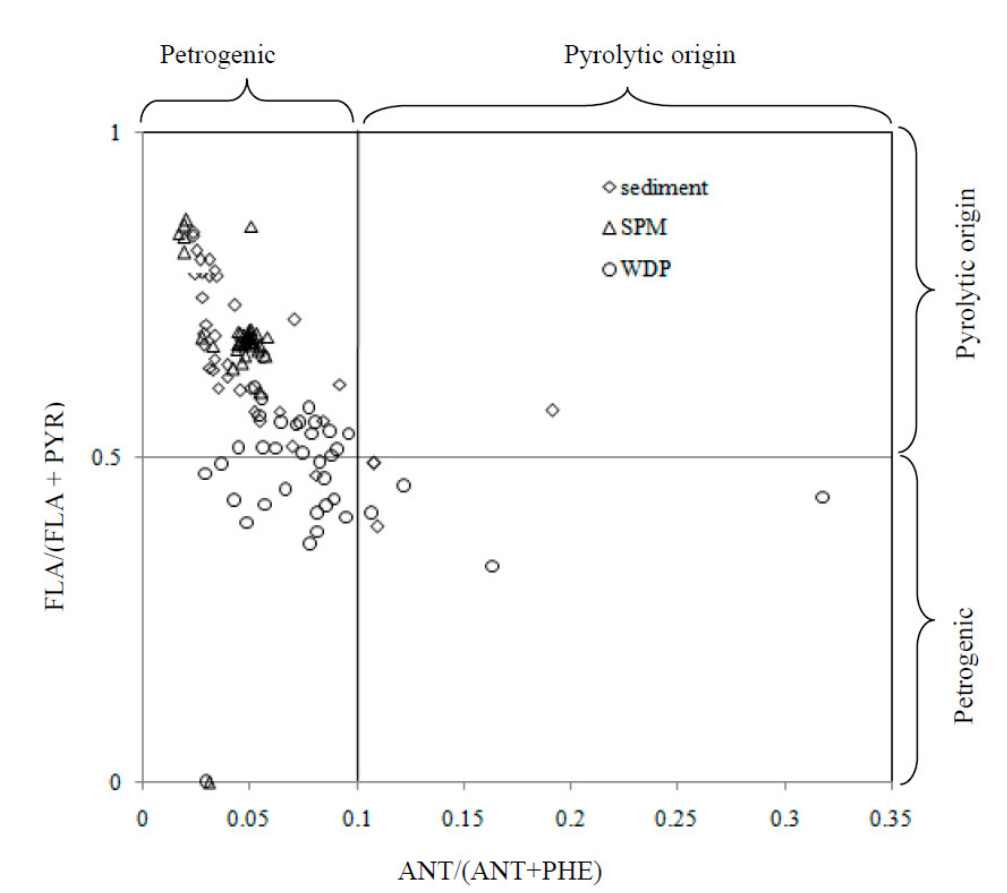
Figure 4. The ratios for ANT/(ANT + PHE) versus FLA/(FLA + PYR) in WDP, SPMs and sediment from Weihe